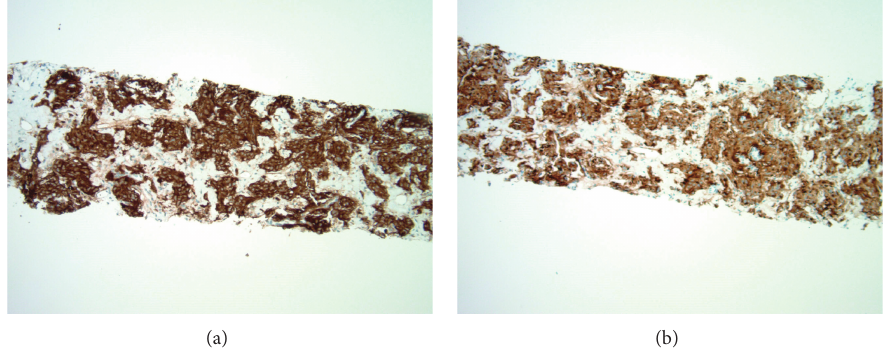
Figure 3: CT guided renal mass biopsy showing positive staining for synaptophysin (a) and chromogranin